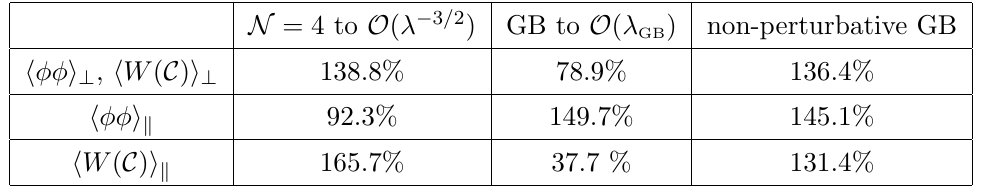
Table 2 . Increase of the critical time in N = 4 SYM theory at (cid:13) (cid:25) 6 : 67 (cid:2) 10 (cid:0) 3 ( (cid:21) (cid:25) 7 : 98) and in a dual of Gauss-Bonnet theory at (cid:21) = (cid:0) 0 : 2. In this case, the choices of the coupling correspond GB to an 80% increase of (cid:17)=s